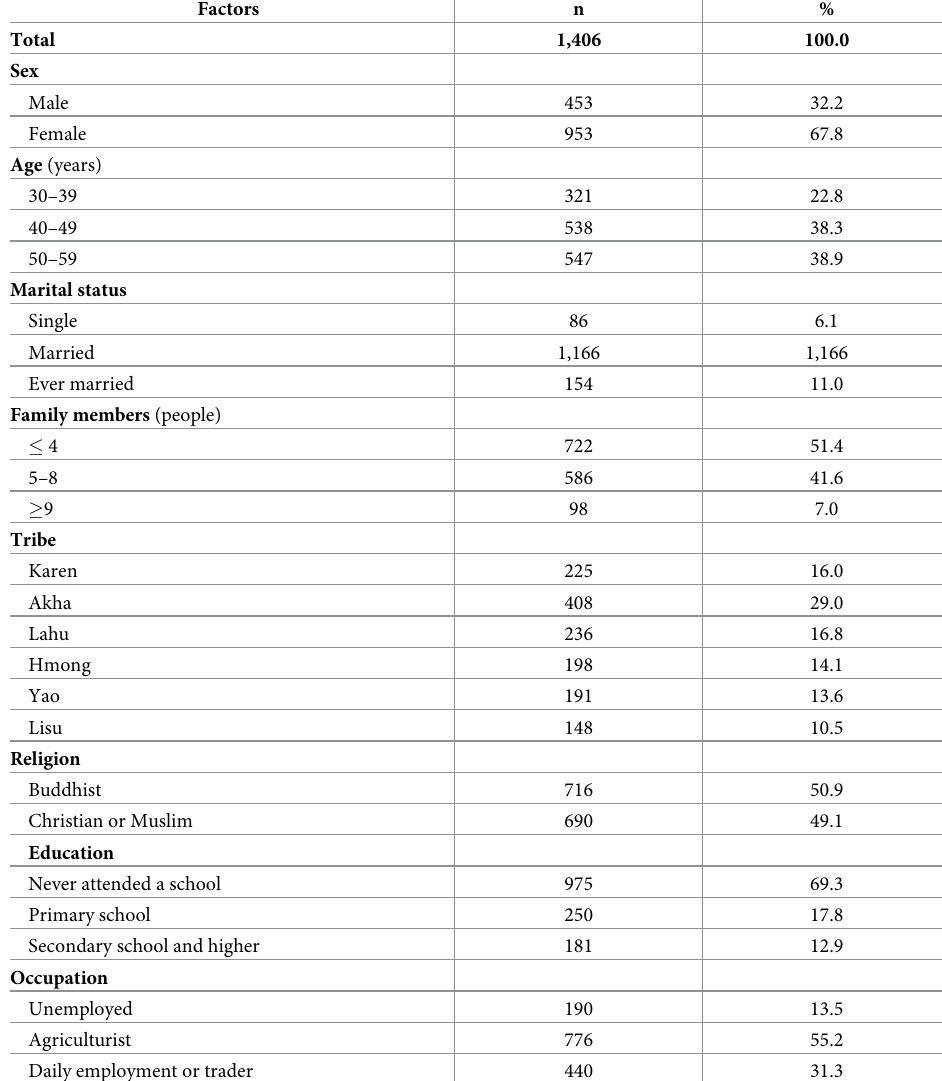
Table 1. General characteristics of the participants.